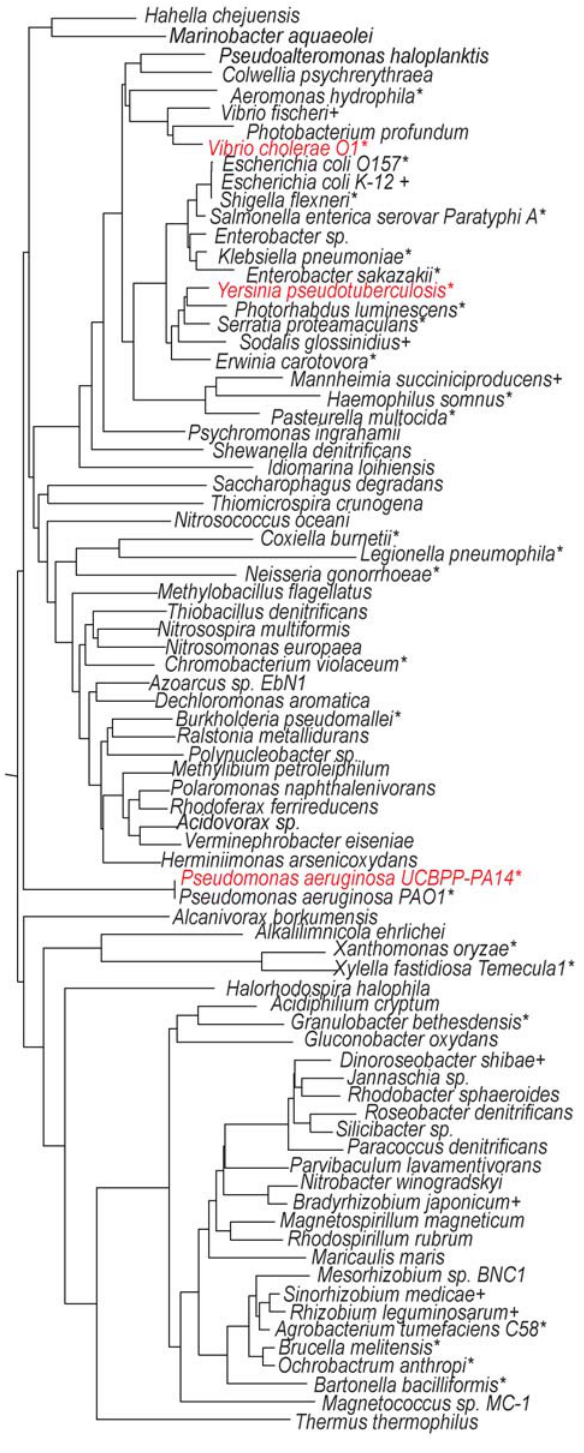
Figure 2. KerV is conserved in Proteobacteria. Phylogenetic tree generated based on selected KerV orthologs using MAFFT in KEGG. The selection criteria were: 1) orthologs with a SW-score over 100; and 2) no more than two representative isolates per genus. * indicates that strains have known pathogenic interactions with eukaryotic hosts; + indicates that strains are known to interact with eukaryotic hosts, but have no known virulence properties. Strains without a label belong to environmental species and do not have substantial known associations with eukaryotes.